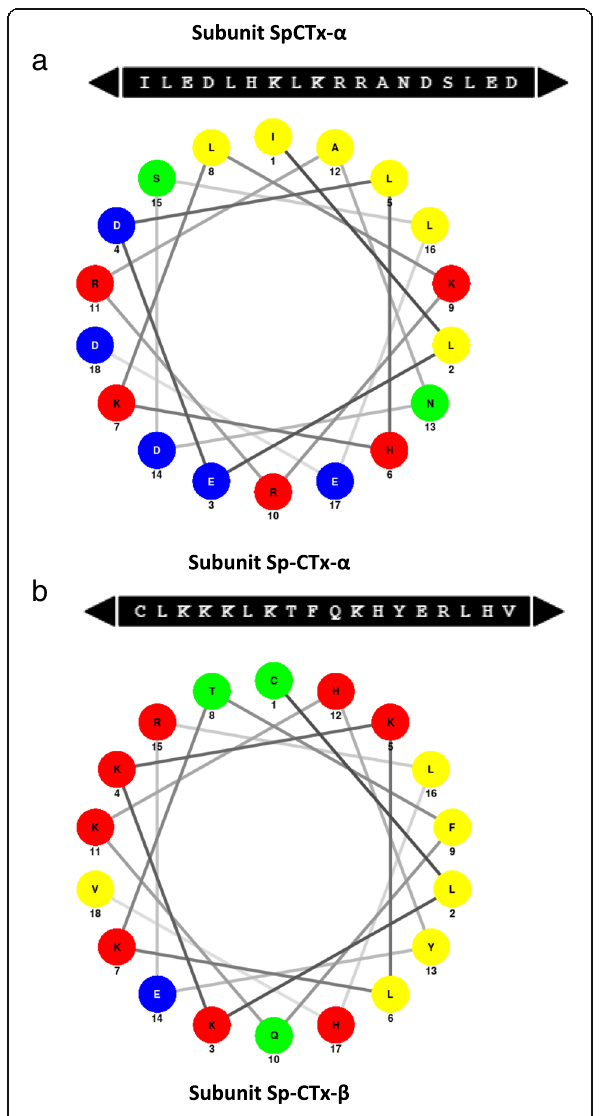
Fig. 4 Predicted amphiphilic α -helices in Sp-CTx α - and β -subunits. Two potential amphiphilic α -helices were predicted by Helical Wheel Projections by Schiffer-Edmundson [39, 40]. Residues are colored according to their chemical character as follows: acidic (blue), basic (red), uncharged polar (green) and nonpolar (yellow). a Amphiphilic α -helix from Ile275 to Asp292 in Sp-CTx- α subunit; b Amphiphilic α -helix from Cys300 to Val311 in the Sp-CTx- β